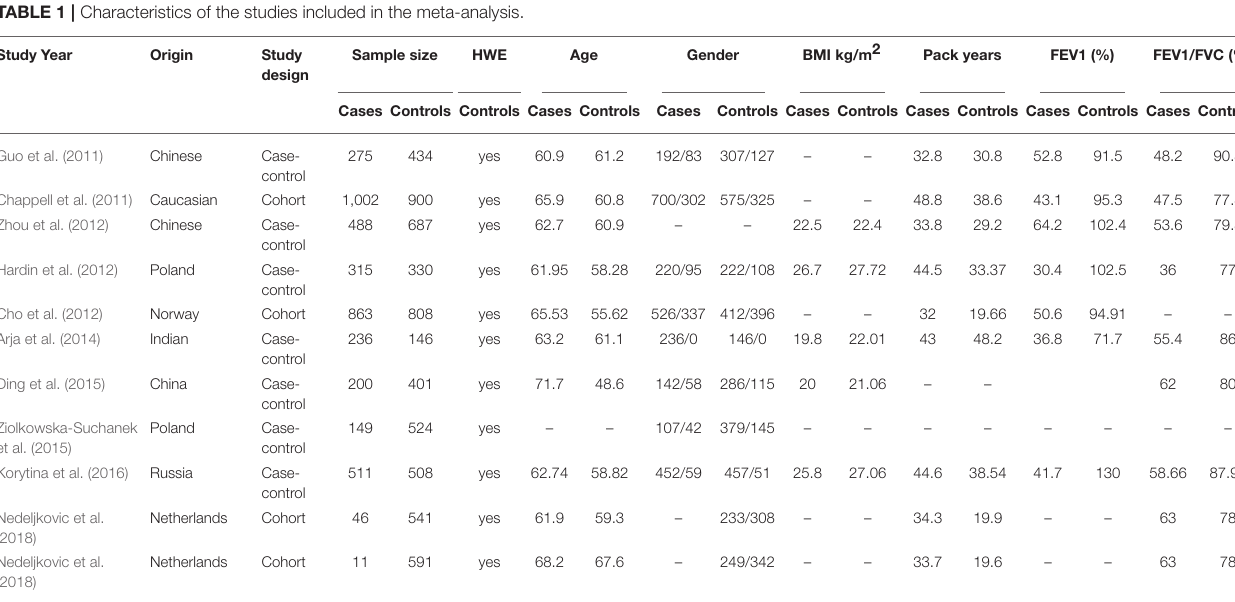
TABLE 1 | Characteristics of the studies included in the